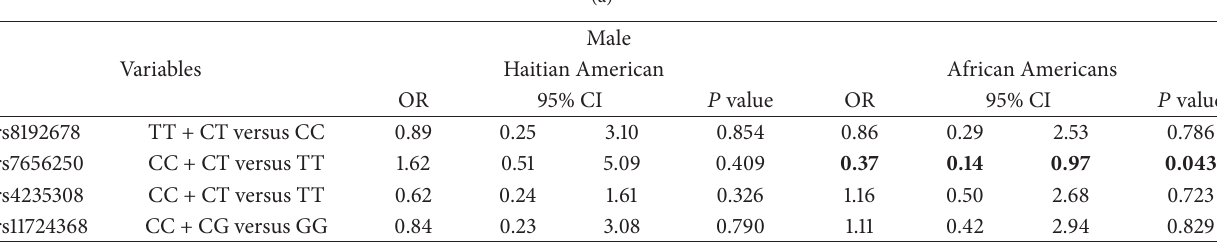
Table 5: (a) Associations of the single nucleotide polymorphisms of PPARGC1A with type 2 diabetes by ethnicities in males. (b) Associations of the single nucleotide polymorphisms of PPARGC1A with type 2 diabetes by ethnicity in